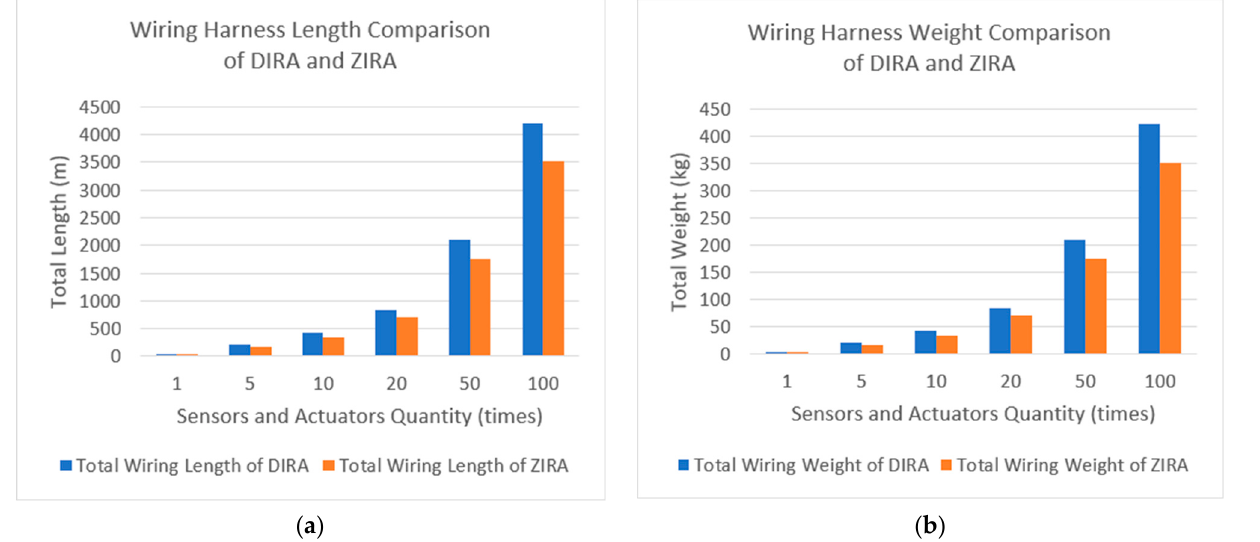
Figure 5. The total length and total weight of the DIRA and ZIRA under different component quantities: ( a ) describes the difference in the total wiring length when DIRA and ZIRA are equipped with different numbers of temperature and pressure sensors. ( b ) describes the difference in the total wiring weight when DIRA and ZIRA are equipped with different numbers of temperature and pressure sensors.